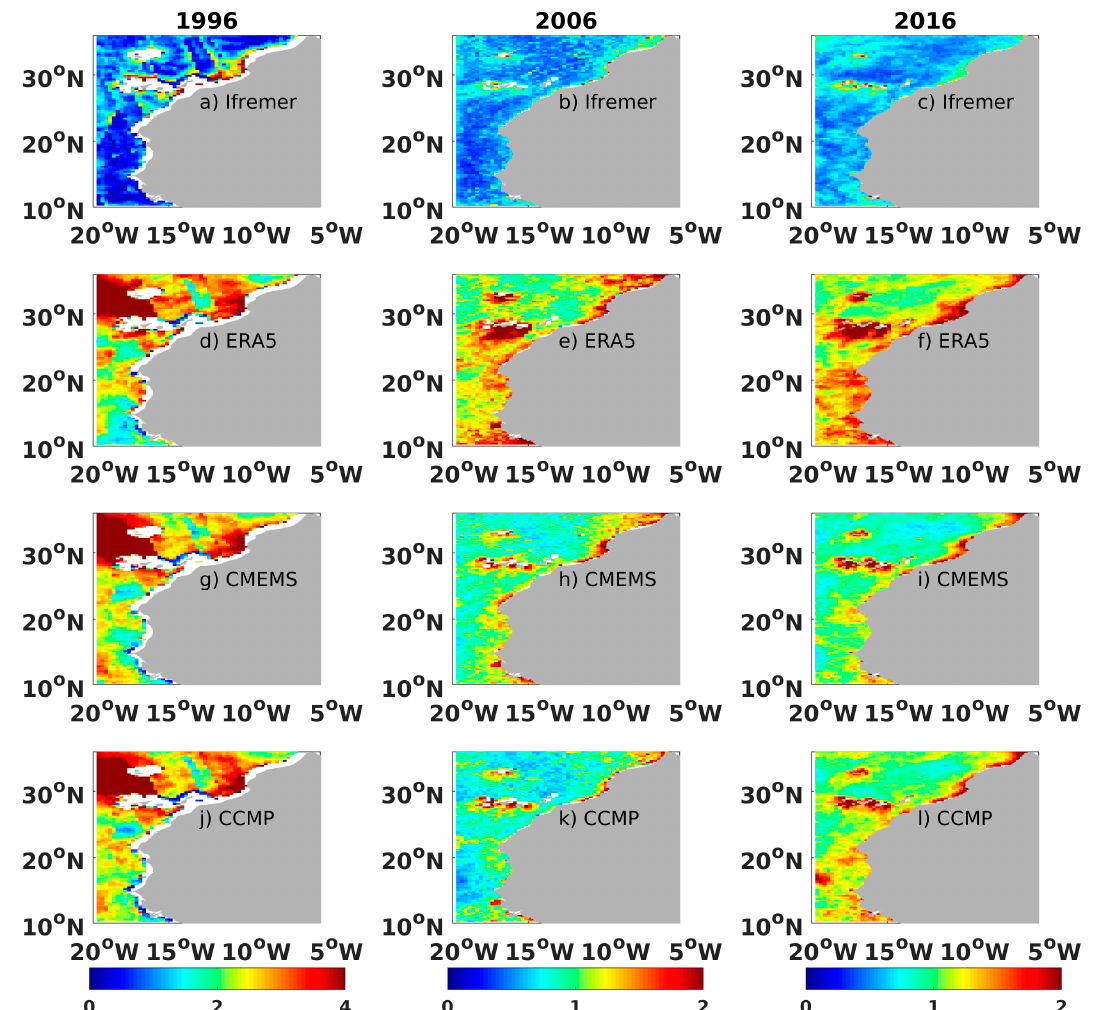
Figure 6. Spatial distribution of root mean square difference (RMSD) between 10 m neutral wind speed from collocated scatterometer retrievals and ( a – c ) IFREMER satellite wind analysis, ( d – f ) ERA5 reanalysis, ( g – i ) CMEMS satellite wind analysis, and ( j – l ) CCMP analysis over the Canary upwelling zone. Note that retrievals from different scatterometers are used in 1996 (ERS2, left column), 2006 (QuikSCAT, middle column), and 2016 (ASCAT, right column). Colors indicate RMSD in m s − 1 . Note that color scale limits for 1996 are different from those in 2006 and 2016.